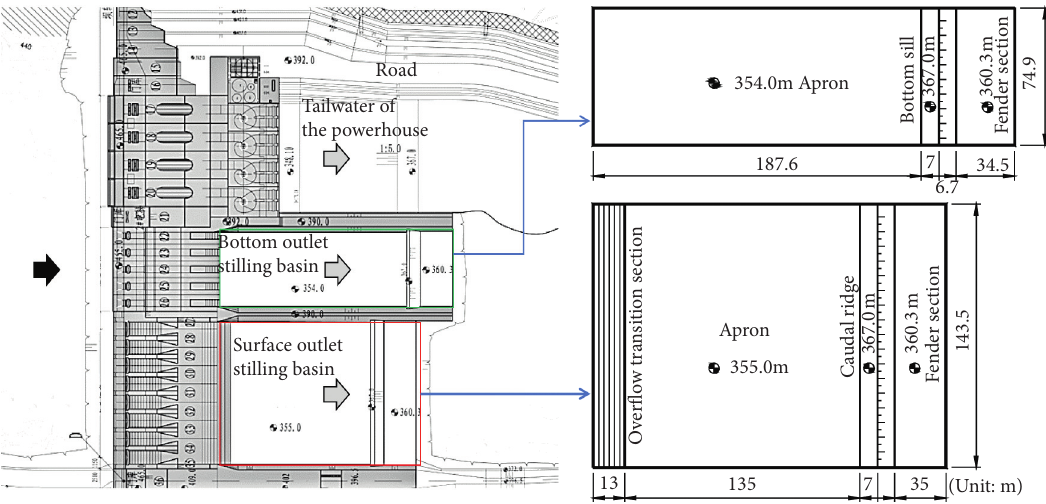
Figure 1: The plan of surface outlet stilling basin and bottom outlet stilling basin.